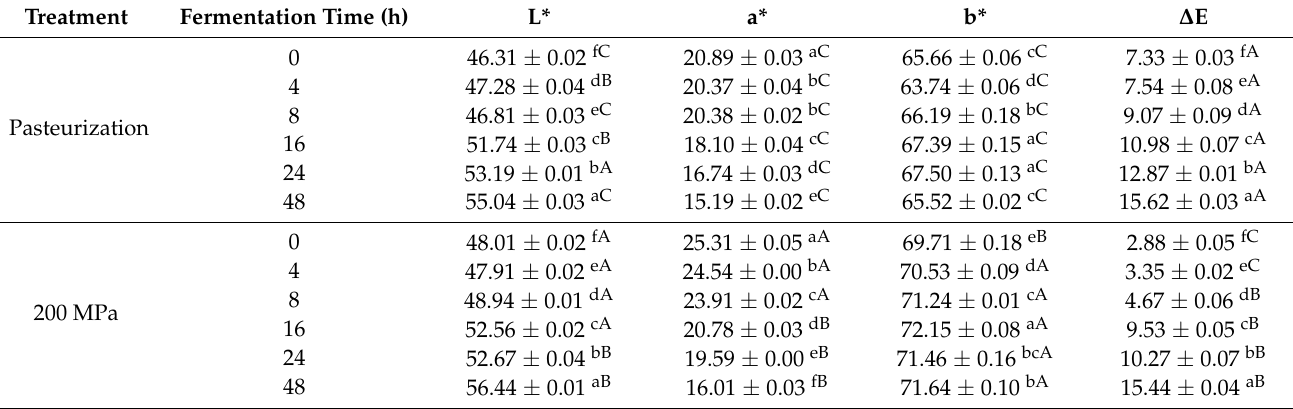
Table 1. Changes in color properties of different treated apple juices as influenced by fermentation. Treatment Fermentation Time (h)